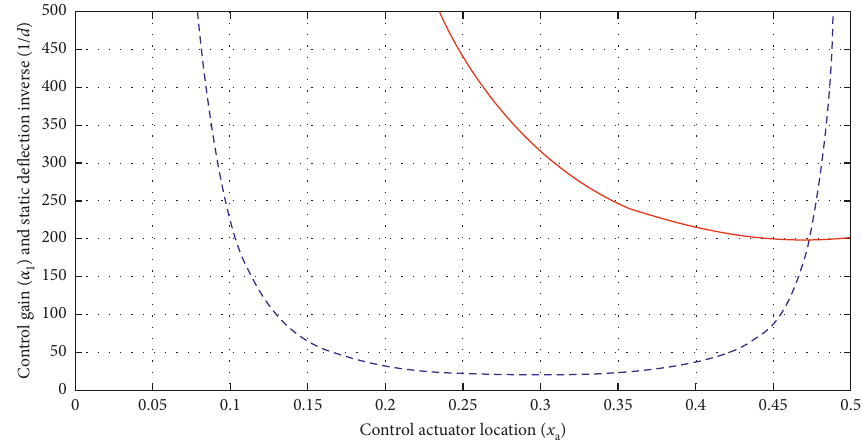
Figure 8: Zoomed control gain ( α